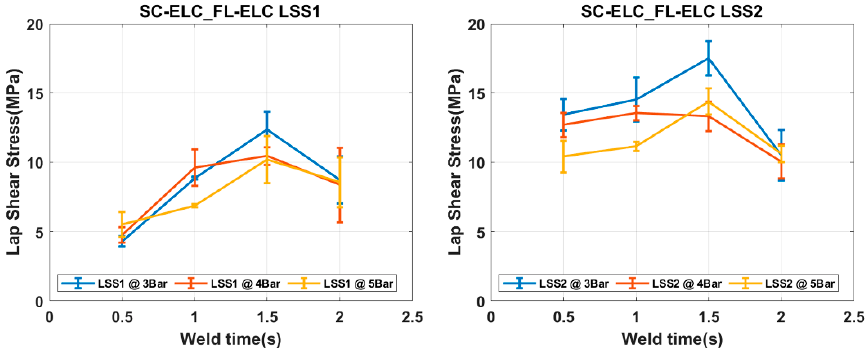
Figure 14. LSS1 and LSS2 graphs for SC-ELC_FL-ELC configuration.